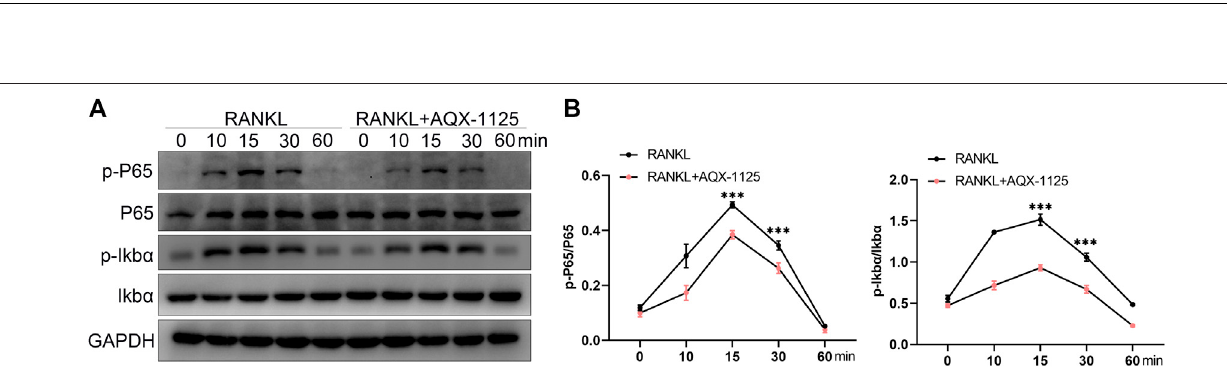
FIGURE 5 | AQX-1125 suppresses the NF- κ B pathway in osteoclastogenesis. (A) Western blotting was used to test the phosphorylation levels ofI κ B α and P65 in thepresenceof50ng/mlRANKLafterpretreatmentwithAQX-1125fortheindicatedtime. (B) QuantitativeanalysisoftheWesternblottingresults.Dataarepresentedas means ± SD from three independent experiments (* p < 0.05; ** p < 0.01; *** p < 0.001).